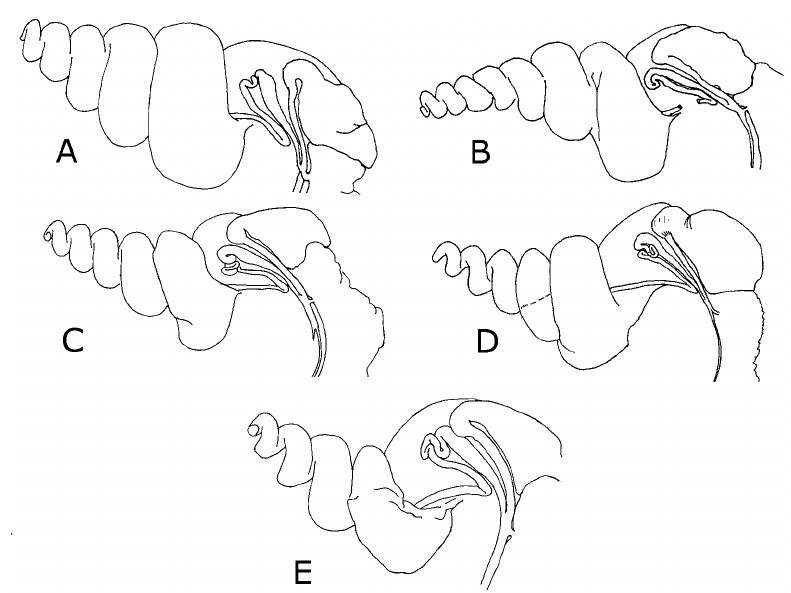
Fig. 15. Comparison of female genitalia. A . Cochlostoma ( Clessiniella ) anomphale Boeckel, 1939. Vellach, Austria (EZ0991). B . Co. ( Cl. ) stelucarum sp. nov., Cornino, Italy (EZ0104). C . Co. ( Cl. ) tergestinum (Westerlund, 1878), Val Rosandra, Italy (EZ0840). D . Co. ( Cl. ) villae (Strobel, 1851), Mizzole, Italy